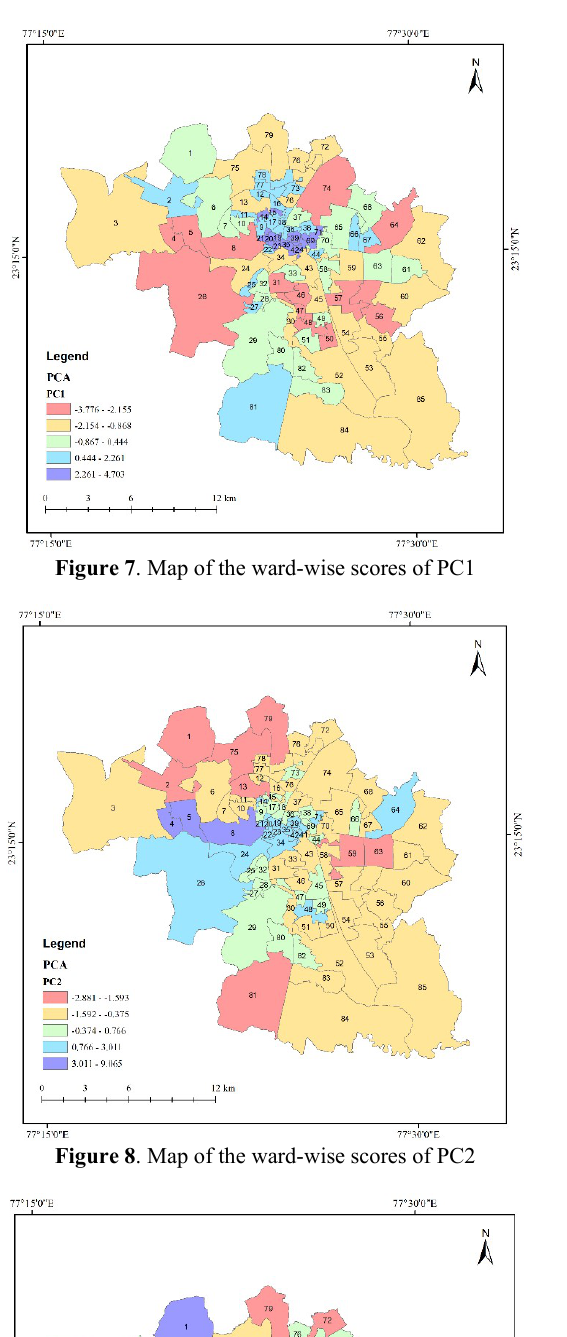
Figure 8 . Map of the ward-wise scores of PC2